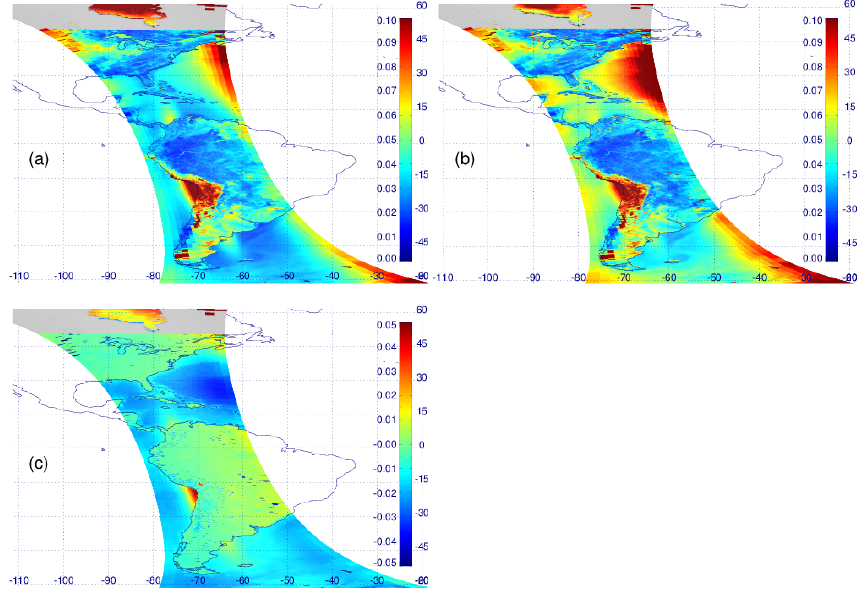
Figure 4. Similar to Fig. 3 but showing geometry-dependent LERs computed for (a) 466nm, (b) 354nm, and (c) their difference: 466nm minus 354nm LER.